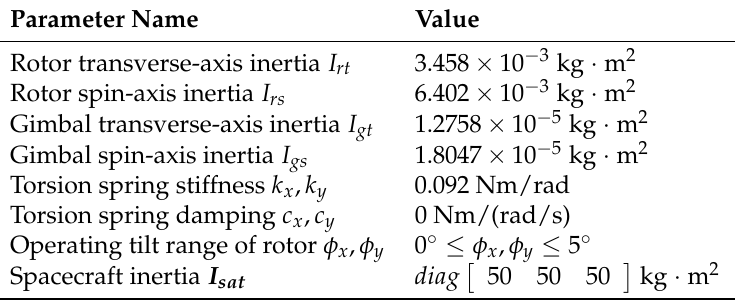
Table 1. Gyrowheel and spacecraft design parameter in